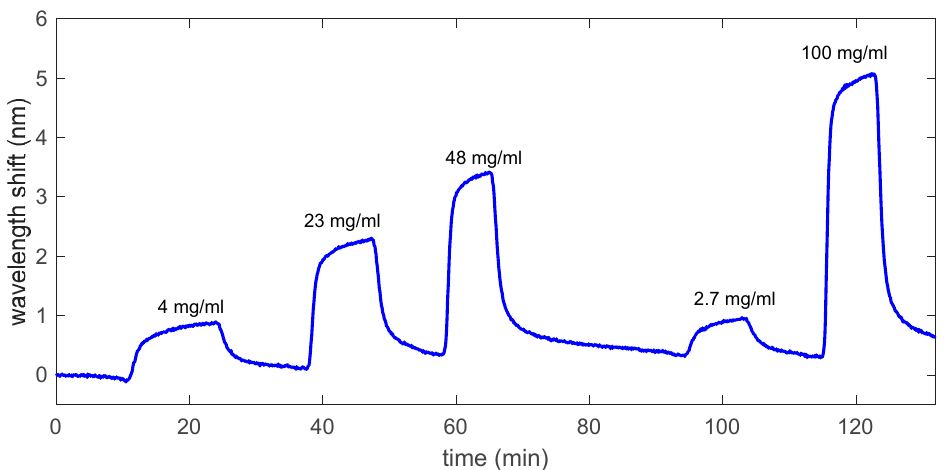
Figure 5. Spectral shift of the interference maximum of the reflection spectrum located at 620 nm when selected concentrations of glucose in DIW are flowed. The raw sensing curve is depicted (i.e., not averaged).